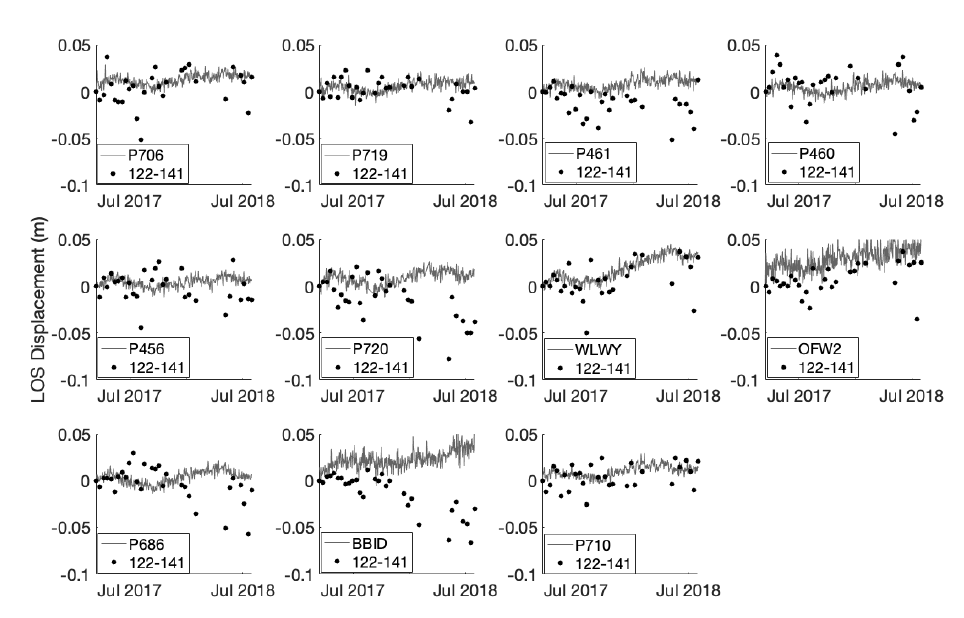
Figure 14. Comparison of GNSS displacement with displacement derived from the corresponding DInSAR pixel in the 122-141 frame. The displacements are shown in the LOS direction of the DInSAR data